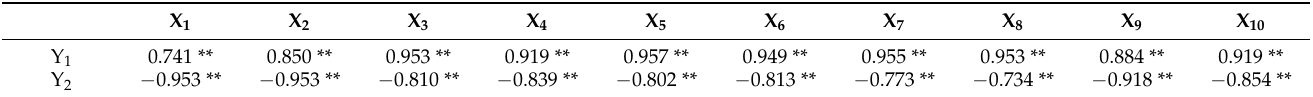
Table 3. Relations among different variables considered in this study.